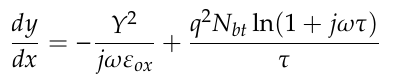
Figure 2. ( a ) Comparison of measured C-V hysteresis of Al/HfAlO/Si MOSCAPs with varying Al content (0%–100%) at 1 MHz frequency. ( b ) Surface trapped charge density (from C–V hysteresis) of Al/HfAlO/Si MOSCAPs according to Al 2 O 3 and HfO 2 intermixing ratio.